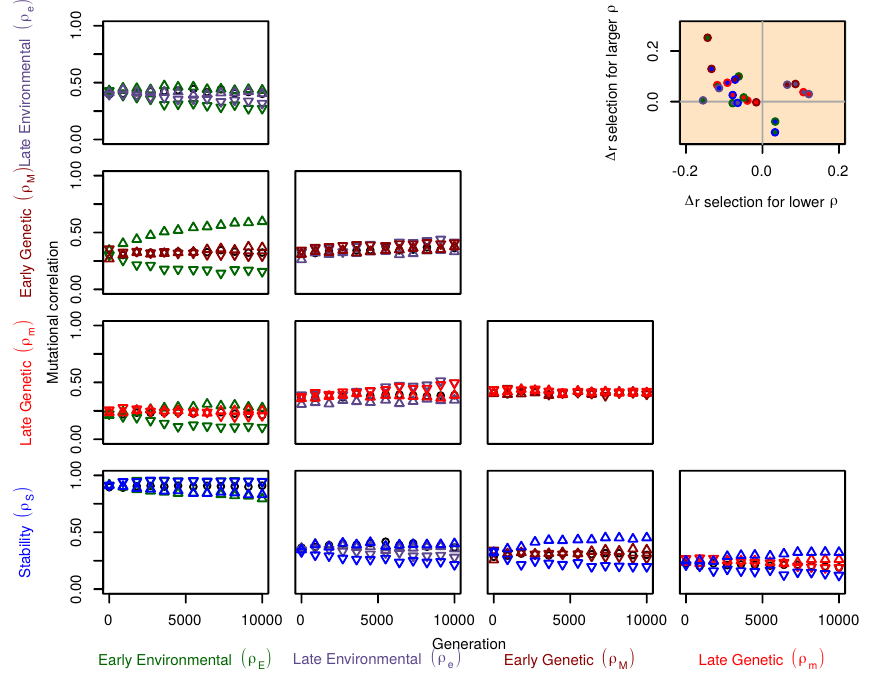
Figure 5 – Evolution of the average mutational correlation under univariate selection on robustness components. Panels, symbols, and colors are the same as in Figure 4. Correla- tions were estimated for each M matrix and averaged over 100 simulation replicates. The color insets shows the (lack of) consistency between the evolution of correlations when selecting for higher (x axis) and lower (y axis) robustness. ∆ r stands for the difference between correlation at generation 10,000 and at generation 1. In the inset, the color of the symbol filling corresponds to the selected robustness component, the color of the symbol border to the correlated robutsness